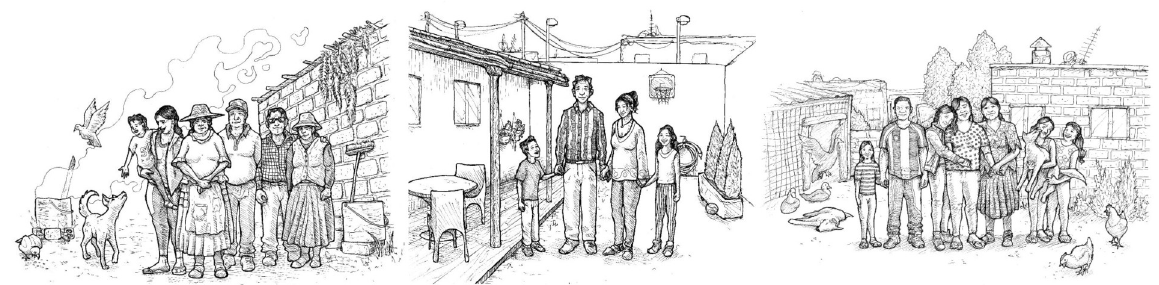
Fig 2. Illustrations representing the most affectively relevant people for each family’s story. Family 1: (on the left) Severina with her husband, Manuel ; their daughter, Janet , carrying her own daughter; and Severina’s sister, Silvia , with her husband. Family 2: (in the middle) Victor and Arminda with their children. Family 3: (on the right) Marta being hugged by her sister and her older daughter Jenny . Next to Jenny , Marta’s husband, Miguel ; their three other daughters.